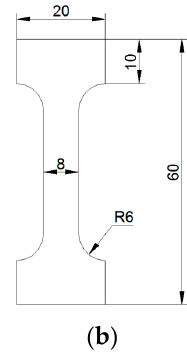
Figure 2. Specimens dimensions in millimeters: ( a )—for elemental analysis, ( b )—for uniaxial tension tests.